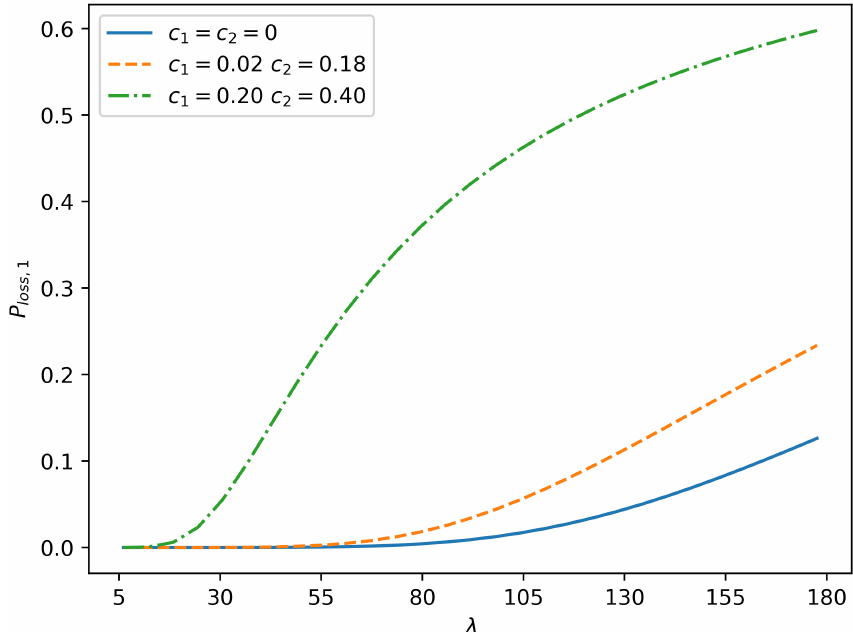
Figure 1. The dependence of the probability P loss ,1 on the input rate λ for the marked Markovian arrival processes ( MMAP s) with different coefficients of correlation.